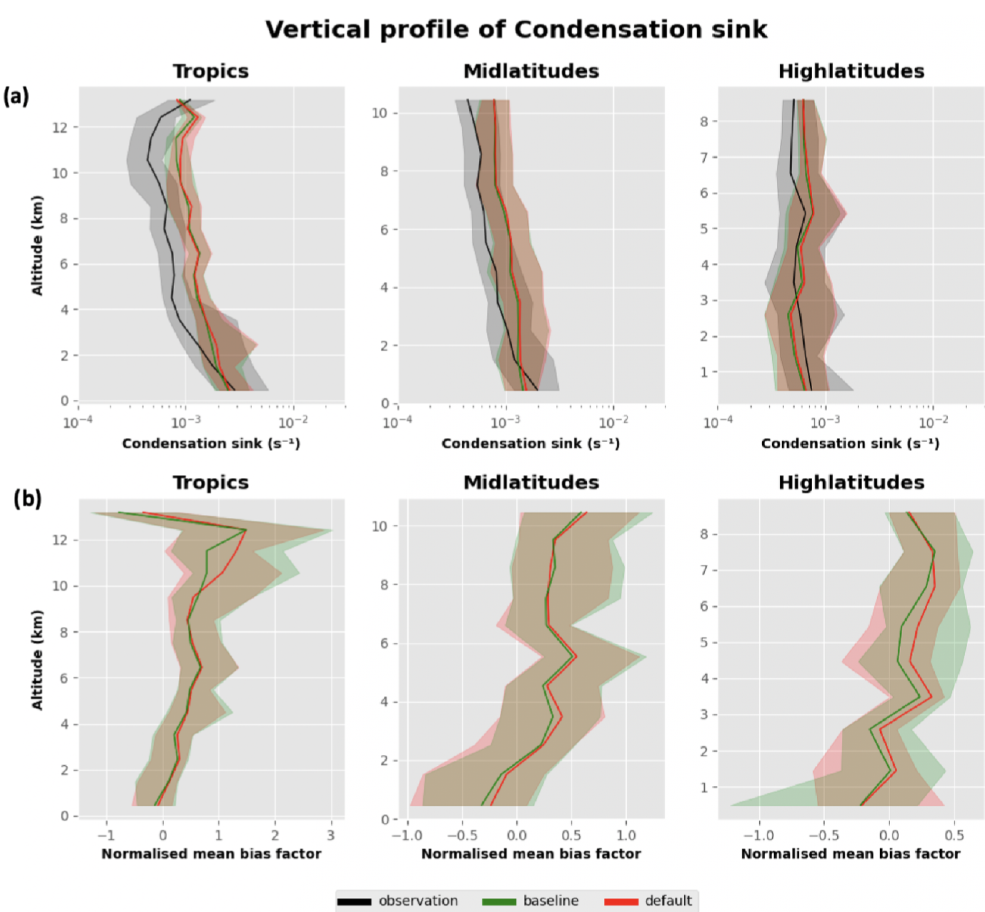
Figure A3. (a) The vertical profile of the dry condensation sink in the atmosphere, as observed, and in simulated data from the default and baseline configurations of UKESM. (b) The vertical profile of the NMBF for the two configurations of the model. The vertical profiles have been provided for the tropics (25 ◦ N–25 ◦ S), mid latitudes (25–60 ◦ N and 25 ◦ S–60 ◦ S) and high latitudes (60–90 ◦ N and 60–90 ◦ S). In both (a) and (b) the bold line represents the median and the shaded region represents the corresponding interquartile range (25th and 75th percentiles) in a 1km altitude